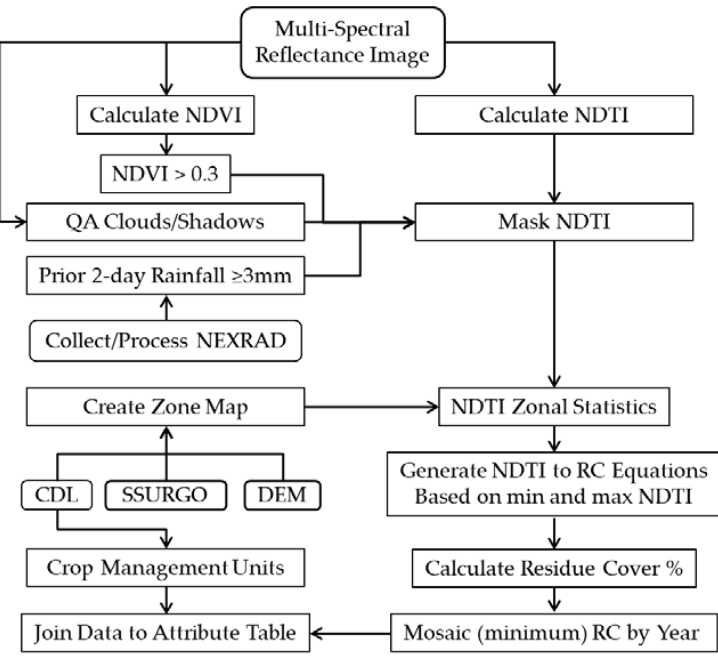
Figure 2. Flow chart for converting satellite images into percent residue cover. The resulting image values can be assigned to field polygons for further analysis.